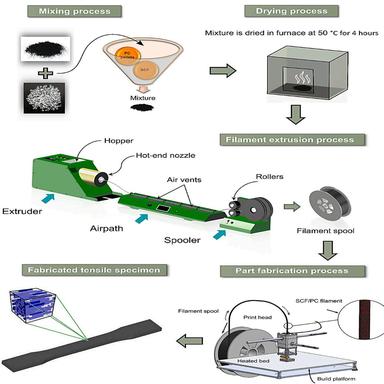
Schematic view of fabricating SCF/PC composite material.